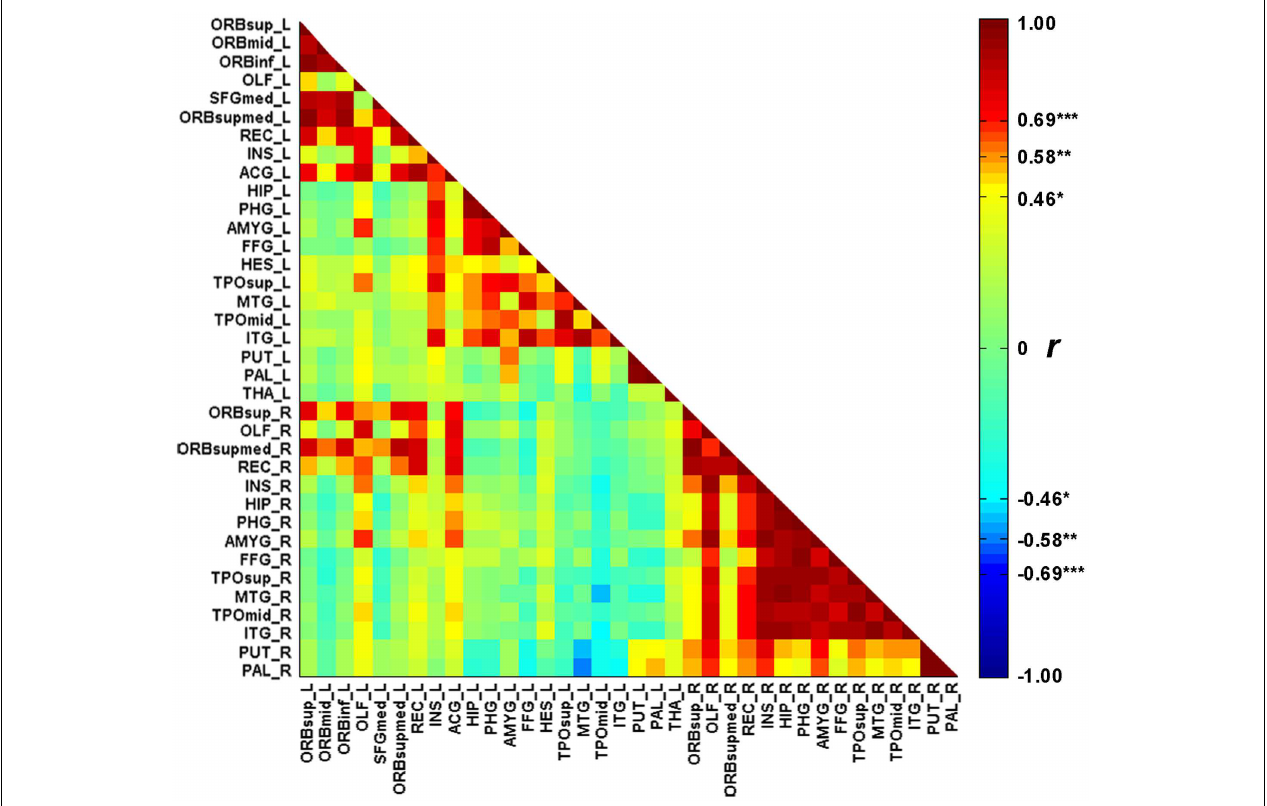
FIGURE 2 | The correlation matrix between the 36 cortical atrophic regions in SD patients. The full names of abbreviations of the regions are given in Table 2 . ∗ p < 0.05, ∗∗ p < 0.01, ∗∗∗ p <